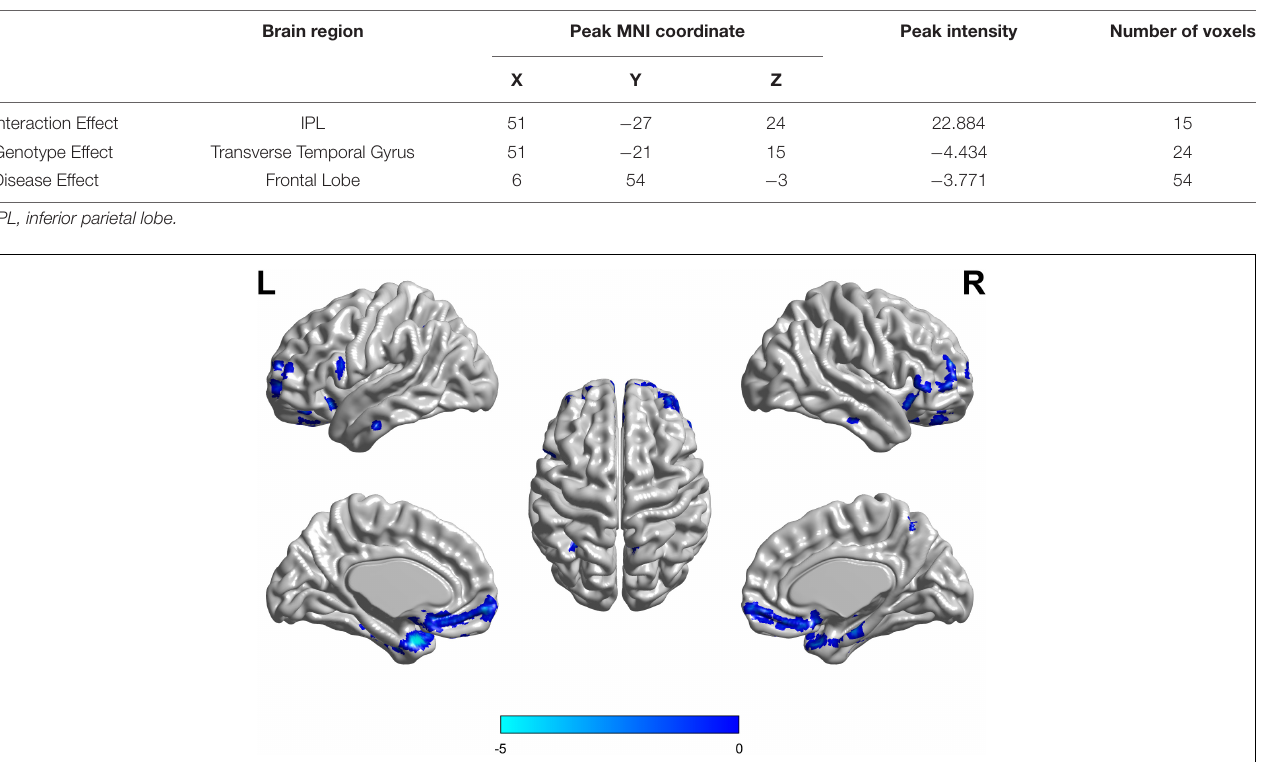
TABLE 2 | Analysis of the covariance (ANCOVA) results across the four groups.